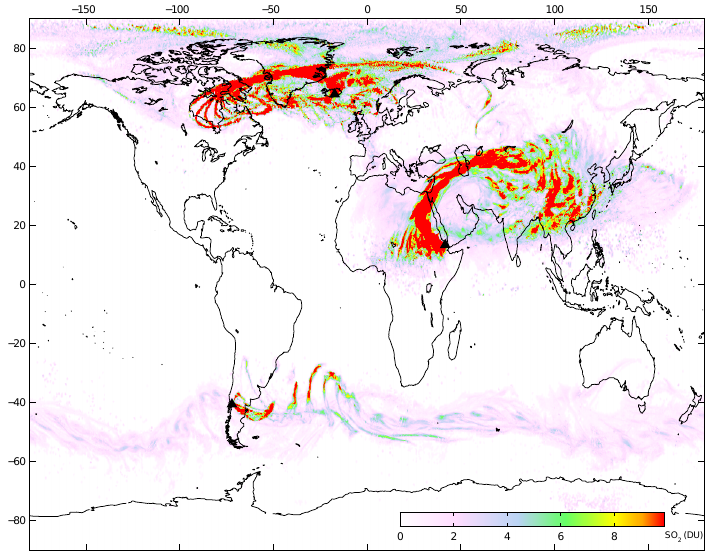
Fig. 12. Composite image of maximum observed SO 2 columns for the period 20 May to 30 June 2011. The value for each grid cell equals the maximum observed SO 2 columns in that grid cell for the given time period during which three major volcanic eruptions took place. Grimsv¨otn ( − 17.33 ◦ , 64.42 ◦ ) erupted first on 21 May, then Puyehue-Cord´on Caulle ( − 40.59 ◦ , − 72.12 ◦ ) on 3 June and finally Nabro (13.37 ◦ , 41.70 ◦ ) on 12 June. A plume altitude of 10km was assumed.